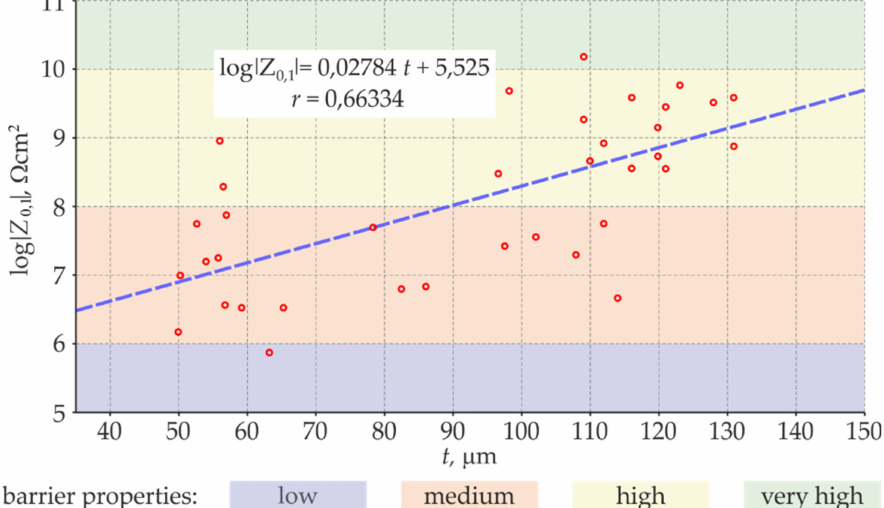
Figure 13. Correlation relationships between the thickness t of the blue coating and the logarithm of impedance modulus Z 0.1 determined at 36 test points.